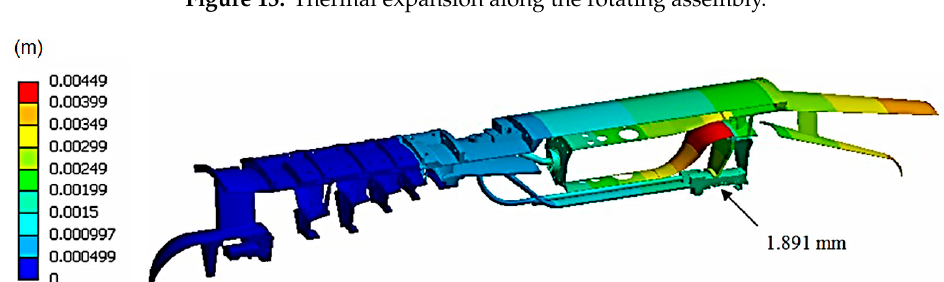
Figure 14. Thermal expansion along the static assembly.